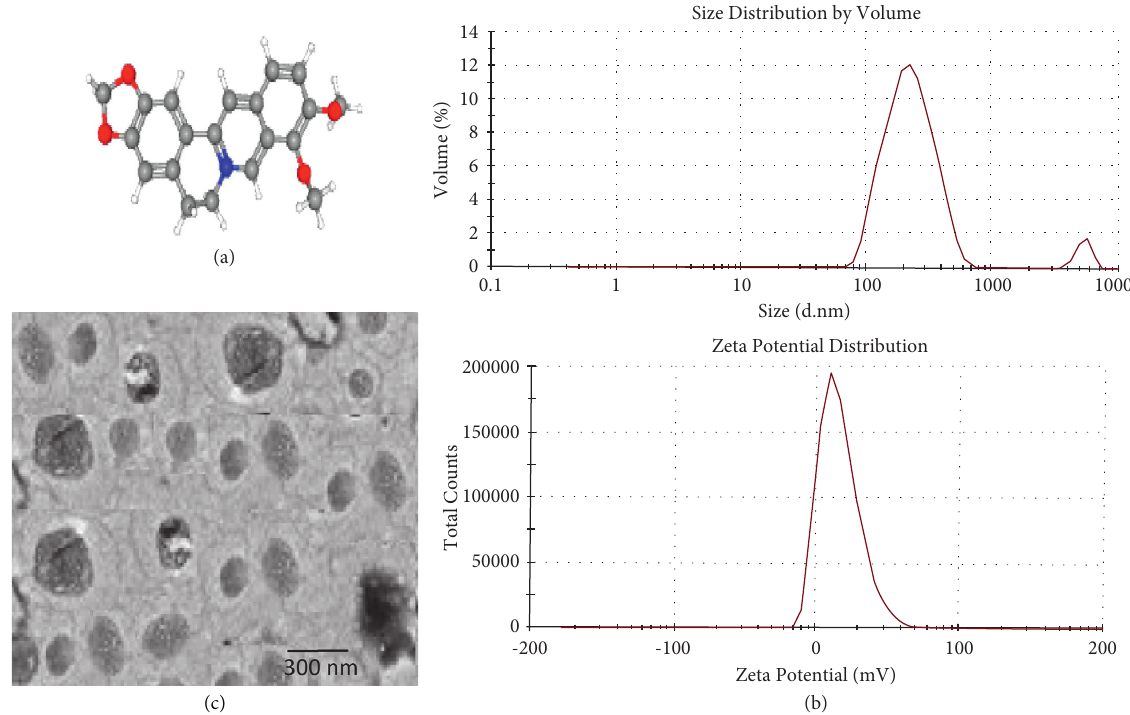
Figure 1: Physiochemical feature of Ber-loaded SLN-chitosan nanoparticles. (a) The chemical structure of berberine. (b) Nanoparticle size distribution and zeta potential. (c) TEM image of prepared Ber-loaded SLN-chitosan